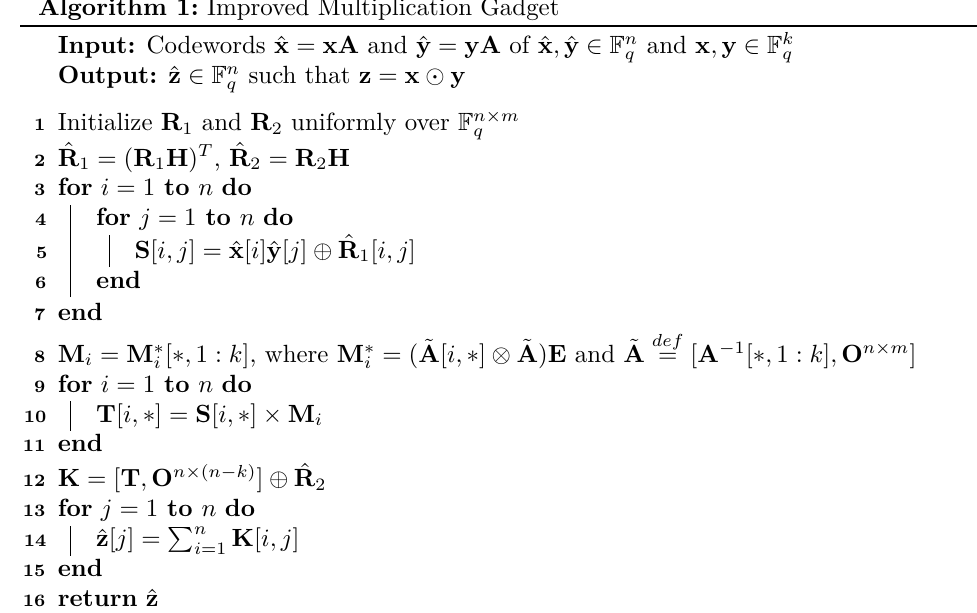
Algorithm 1: Improved Multiplication Gadget